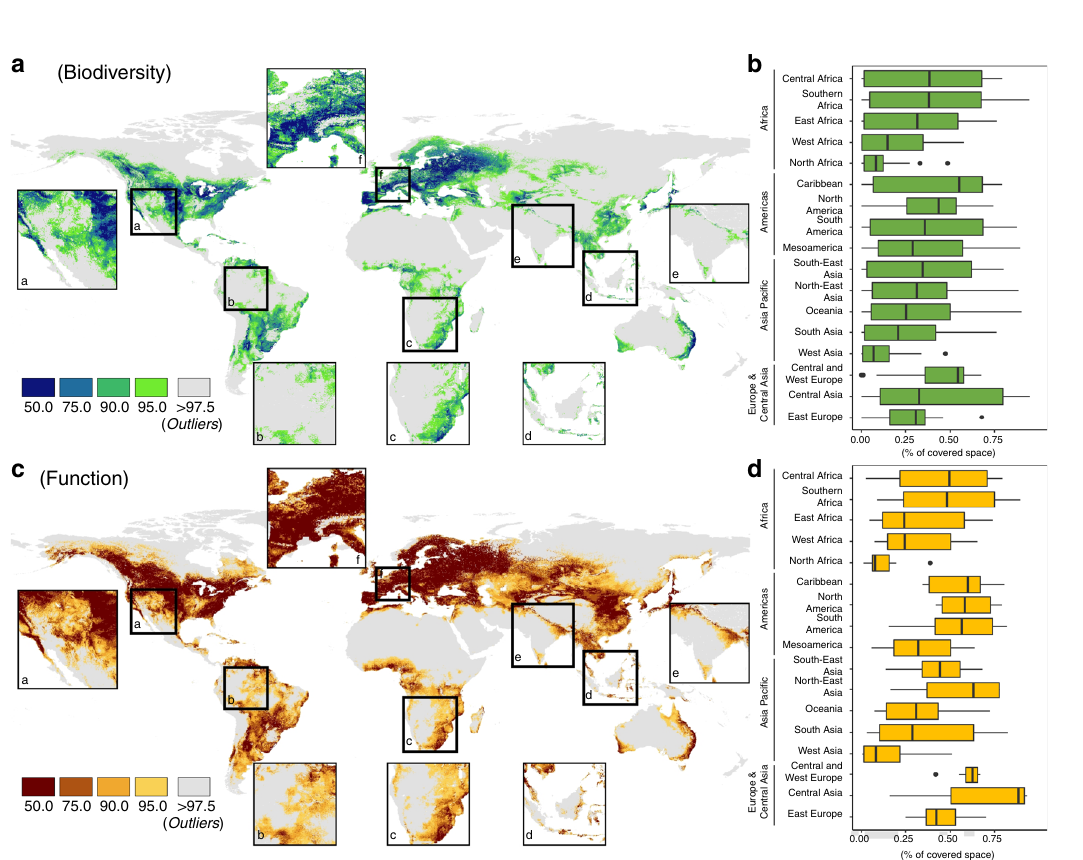
Fig. 2 Global soil ecological blind spots. Values ( y -axis) correspond to the percentage of sites per study when compared with the global percentage distribution (e.g., a value of 20% means that a given study overrepresents a given environmental variable by 20%, when compared to the global distribution of that same variable). Soil biodiversity studies in green ( N = 35) and ecosystem function studies in orange ( N = 12). a soil carbon (g soil kg − 1 ) 127 ; b sand content (%) 127 ; c soil pH 127 ; d clay content (%) 127 ; e silt content (%) 127 ; f potential evapotranspiration (mm/day) 128 ; g aridity index 128 ; ( h ) precipitation seasonality 129 ; ( i ) temperature seasonality 129 ; j mean annual temperature (°C) 129 ; k mean total precipitation (mm) 129 ; l elevation (meters) 130 ; m vascular plant richness 73 ; n land cover 131 ; and o soil type 127 . The zero black line corresponds to a situation where the proportion of sites in a given class within a study matches the global proportional representation of the same class. Although outliers were not eliminated, for representation purposes these were omitted >800% between panels a – l and >3000% for panels m – o . The class intervals of each continuous variable were obtained based on a natural breaks (Jenks) classi fi cation (20 classes). Each barplot (quantile distribution) represents the proportional number of sampling sites covering a particular class when compared to the global distribution. In panel ( n ) mosaic (crops) represent small scale landscapes dominated by crops, while mosaic (forests) represent small scale landscapes dominated by forests.